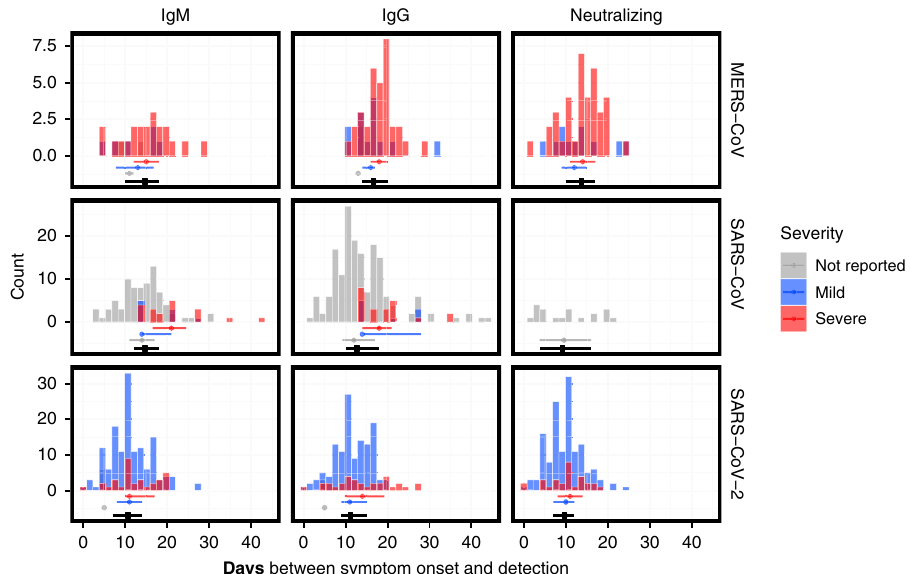
Fig. 2 Distributions of times from symptom onset to detection of antibodies. Times between symptom onset and the detection of IgM (left column), IgG (middle column), and neutralizing antibodies (right column), for MERS-CoV (upper row), SARS-CoV (middle row), and severe acute respiratory syndrome coronavirus 2 (SARS-CoV-2) (bottom row). Dots and lines below each histogram indicate the median values and interquartile range (IQR) across all severity ratings (black), mild symptoms (blue), severe symptoms (red), and no reported severity (gray). Data were digitized from